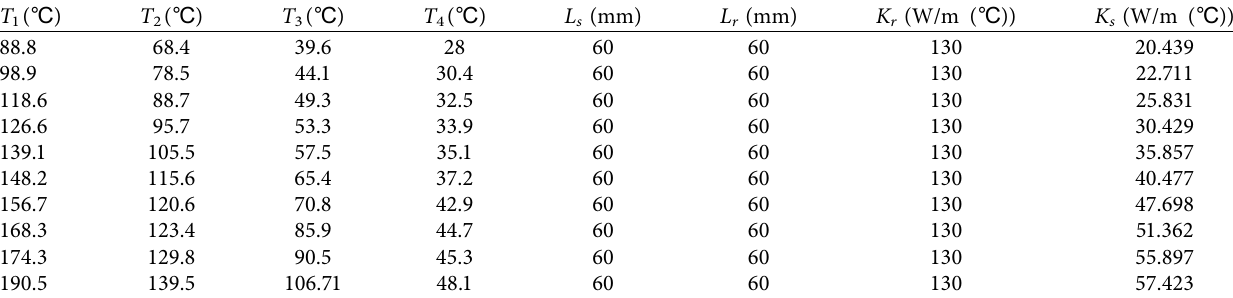
Table 7: Thermal conductivity (W/m ( ℃ ) ) of Ni-Cu +9% TiO